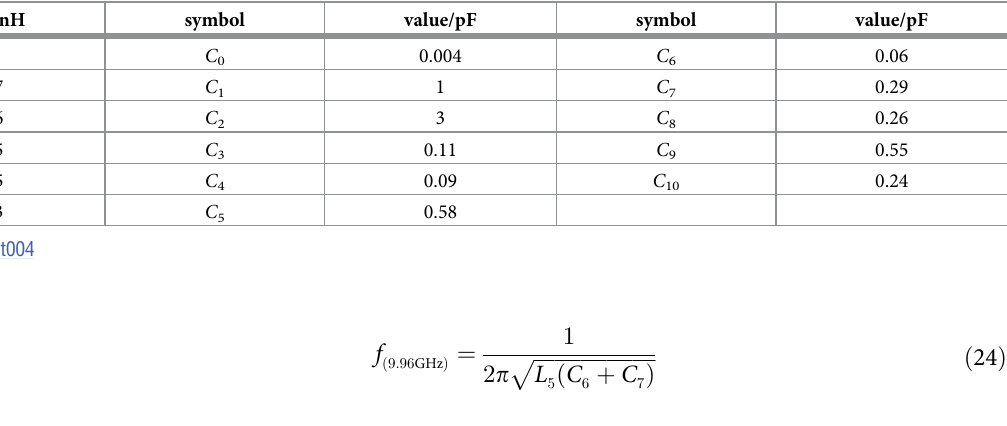
Table 4. Optimized lumped parameters.